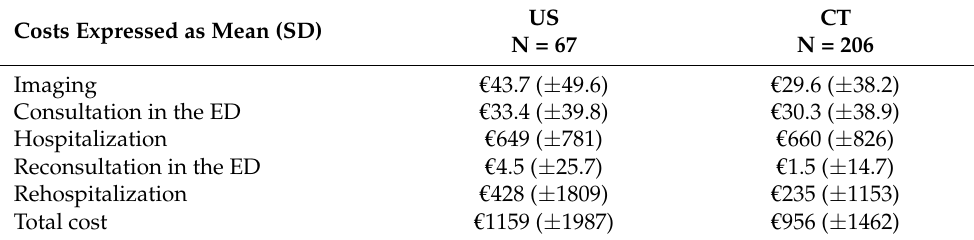
Table 3. Costs and effectiveness for each strategy of imaging (weighted endpoints).